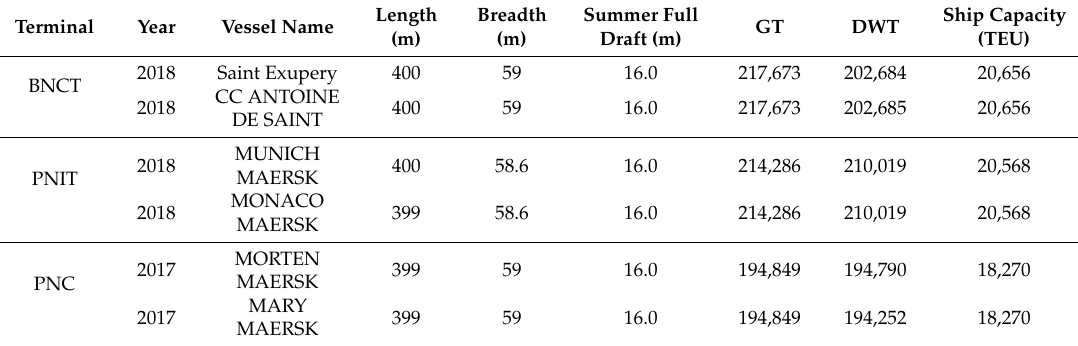
Table 2. The Information of Vessels Entering in Busan Port.